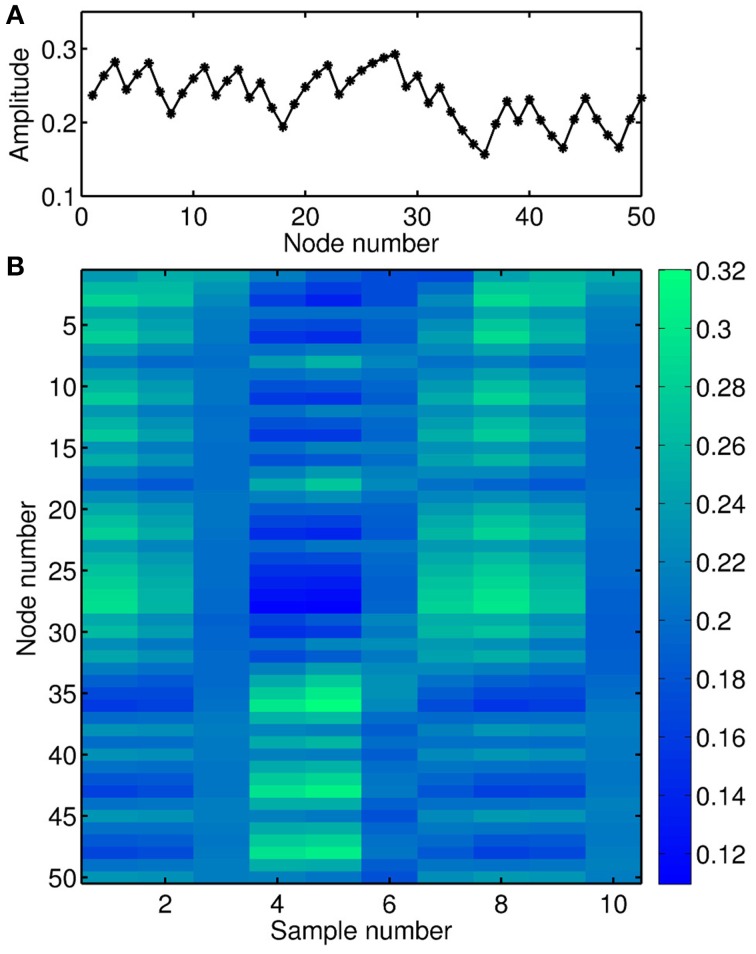
Illustration of the nonlinear transient dynamics. (A) Temporal sequence of the response to the signal depicted in Figure 3C. (B) Matrix representation of the response signal to the input matrix depicted in Figure 3B. Parameter values in Equation (3) are τ = 10, β = 0.7, and ϕ = -π/4, respectively.